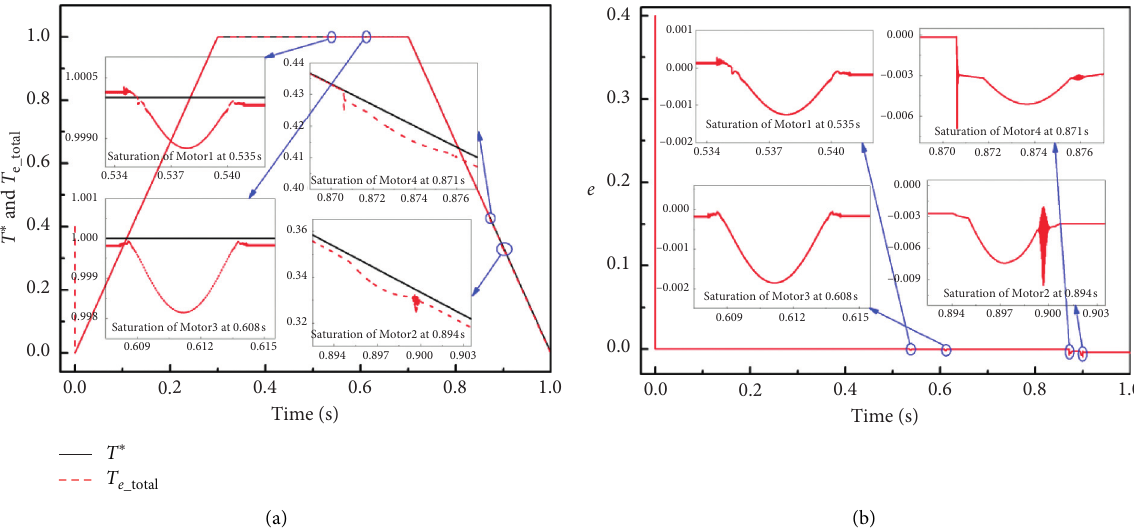
practicability of the control strategy proposed herein. A multimotor traction system consisting of four motors with different parameters was used as a simulation object. Table 1 lists the parameter settings for each individual motor. The initial torque of each motor was set as 0.1. In controller equation (19), the sliding-mode parameters ε j of each motor were set as 100. The desired traction characteristic curve was composed of a piecewise function: the motor acceleration phase ( 0 ⟶ 0 . 3s ) , constant-speed motor operation phase ( 0 . 3 ⟶ 0 . 7s ) , and motor-braking phase ( 0 . 7 − 1s ) . These phases are indicated in equation (24).